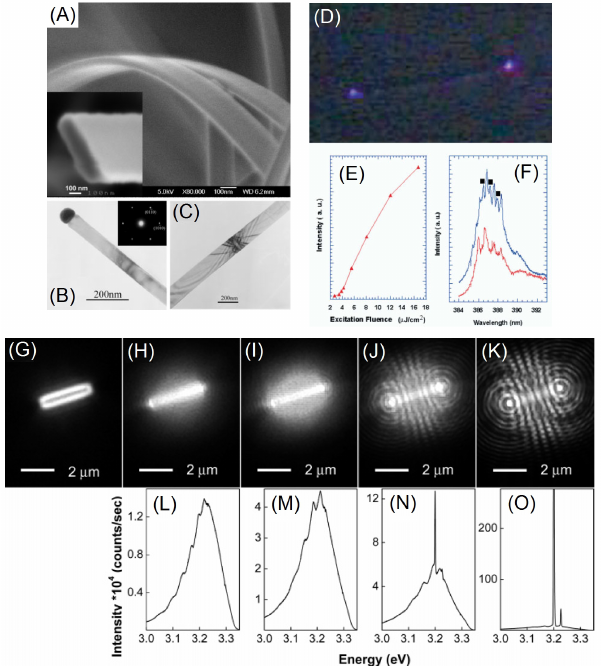
Figure 11: (A–C) SEM and TEM images of ZnO nanoribbons. (D) PL far-field image of a ZnO nanoribbon. (E) Integrated emission inten- sity against excitation power of the corresponding nanoribbon.